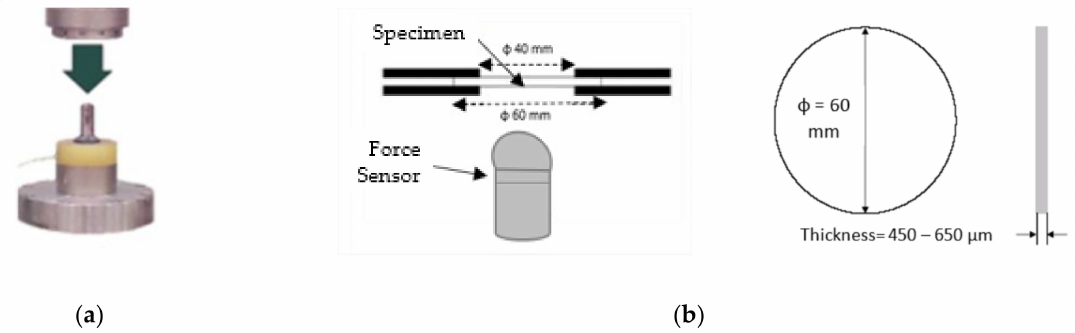
Figure 3. ( a ) Puncture impact scheme; ( b ) Impactor and specimen.